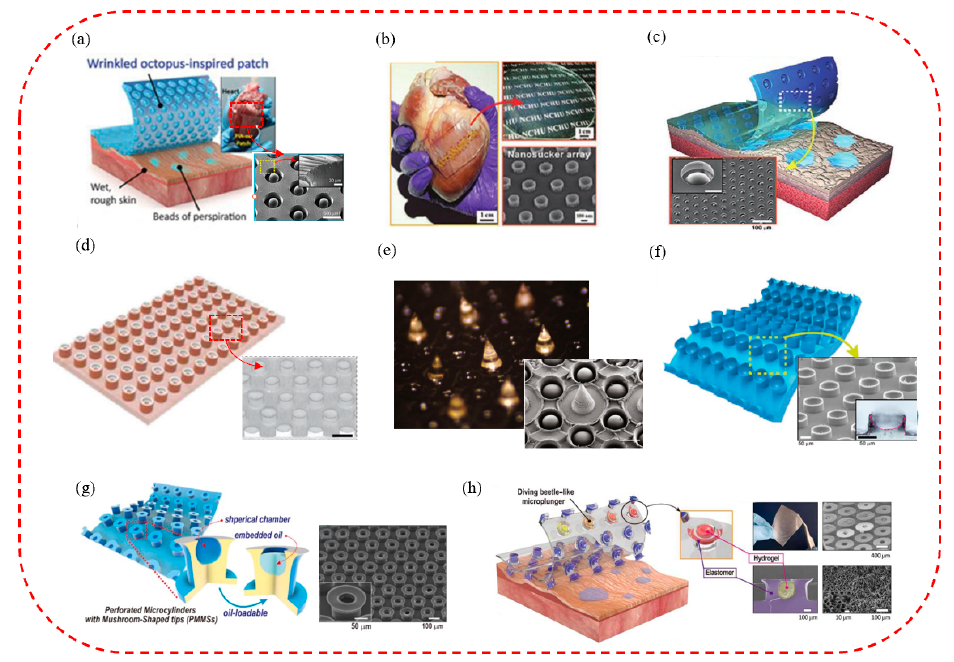
Figure 8. The bionic suction cup patches used for medical treatments. ( a ) An attachment patch inspired by the soft wrinkles of miniaturized 3D octopus suction cups (reproduced with permission from [180], American Chemical Society, Copyright 2019). ( b ) The assembly of nano − sucker arrays for dry/wet attachment inspired by the octopus (reproduced with permission from [181], American Chemical Society, Copyright 2017). ( c ) A wet − tolerant a tt achment patch inspired by protuberances of the sucker of the octopus (reproduced with permission from [182], NATURE PORTFOLIO, Cop- yright 2017). ( d ) A biocompatible wound − healing patch with individualized design and selective attachment by using tailorable patterns (reproduced with permission from [183], Huang Rongkang et al., Copyright 2021). ( e ) The bioinspired attached and antibacterial microneedles. They can be used for versatile transdermal drug delivery (reproduced with permission from [184], Zhang Xiao- xuan et al., Copyright 2020). ( f ) The highly adaptable and biocompatible attachment patches in- spired by an octopus with meniscus − controlled unfolded 3D microchips for hairy skin and under- water surfaces (reproduced with permission from [170], Baik Sangyul et al., Copyright 2018). ( g ) The male diving beetle-inspired a tt ached oil − loadable perforated microcylinders with mushroom- shaped tips (PMMSs). They can load oil in their spherical chambers (reproduced with permission from [185], Elsevier B.V., Copyright 2021). ( h ) The male diving beetle − inspired miniaturized plung- ers with rapid and reversible biofluid capturing for skin disease care based on machine learning (reproduced with permission from [186], Baik Sangyul et al., Copyright 2021). Researchers have also been actively exploring solutions that can be used for rapid wound recovery and healing, and have developed a variety of related micro-suction cup patches. For example, a reversible dry/wet attachment system inspired by the dome-like